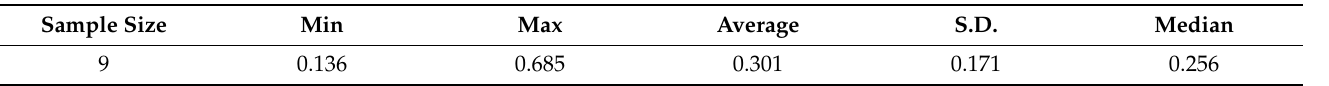
Table 6. Comprehensive index analysis of talent competitiveness of the intelligent industry in nine provinces and cities. Sample